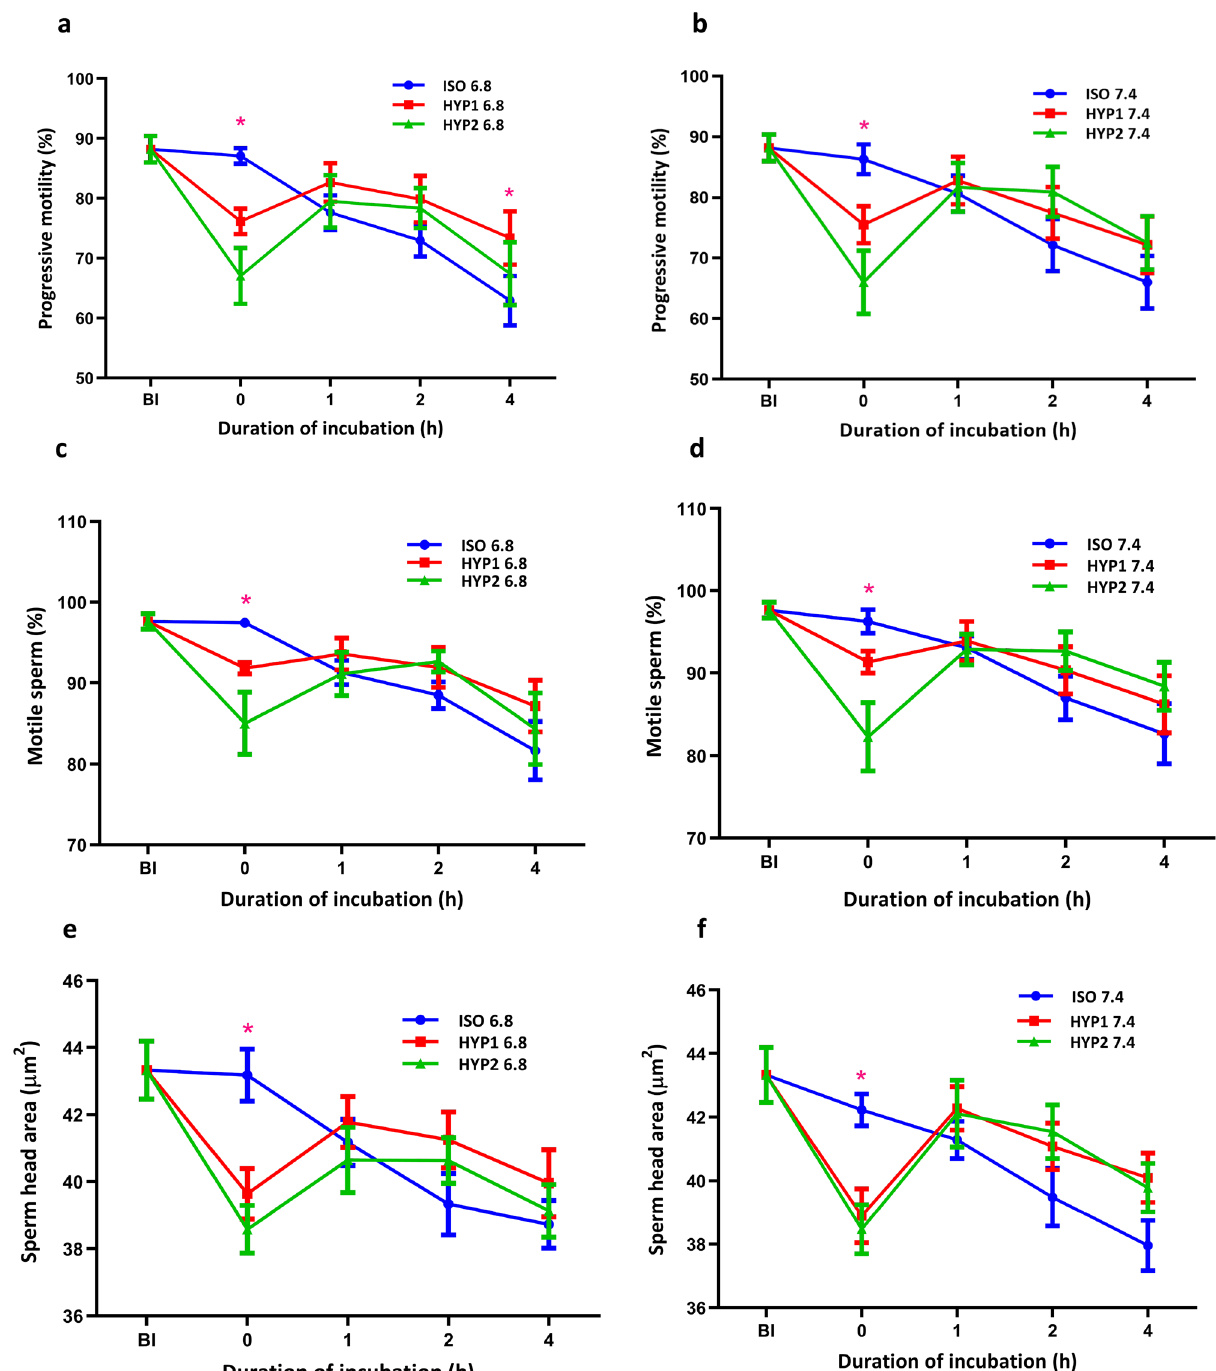
Figure 1. Effect of osmolality and pH on bovine sperm progressive, total motility and head area in vitro. The hyperosmotic (HYP1) uterine ( a ) and oviduct ( b ) environment significantly ( p < 0.05) decreased the progressive motile sperm at 0 h and regained the same at 1 h of incubation. The progressive motility ( a ) was significantly higher at 4 h of incubation in HYP1 as compared to ISO only at pH 6.8. Though the total motility differed significantly at 0 h of incubation in both pH, no significant difference was observed in other time periods of both pH 6.8 ( c ) and 7.4 ( d ). The hyperosmotic (HYP1) uterine ( e ) and oviduct ( f ) environment significantly ( p < 0.05) decreased sperm head area at 0 h and regained at 1 h of incubation. The interaction between osmolality and incubation time was significant ( p < 0.05) for sperm progressive motility, total motility and head area. *represent the effects of osmolality, differ significantly ( p < 0.05) at a particular time point. (ISO: 290 mOsm/kg; HYP1: 355 mOsm/kg; HYP2: 420 mOsm/kg; BI:Before